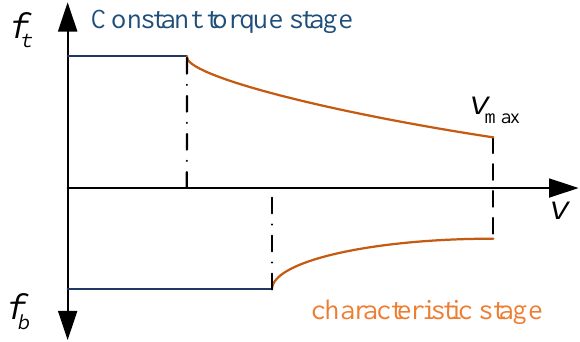
Figure 2. Train traction and braking characteristic curve.